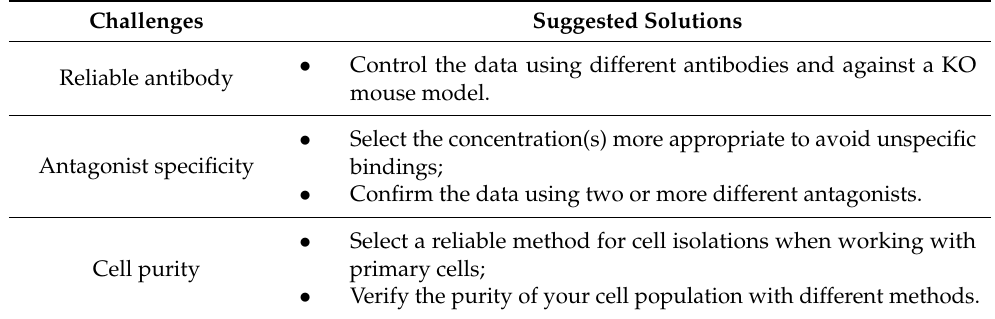
Table 2. Challenges and suggested solutions in studying the receptor P2Y 12